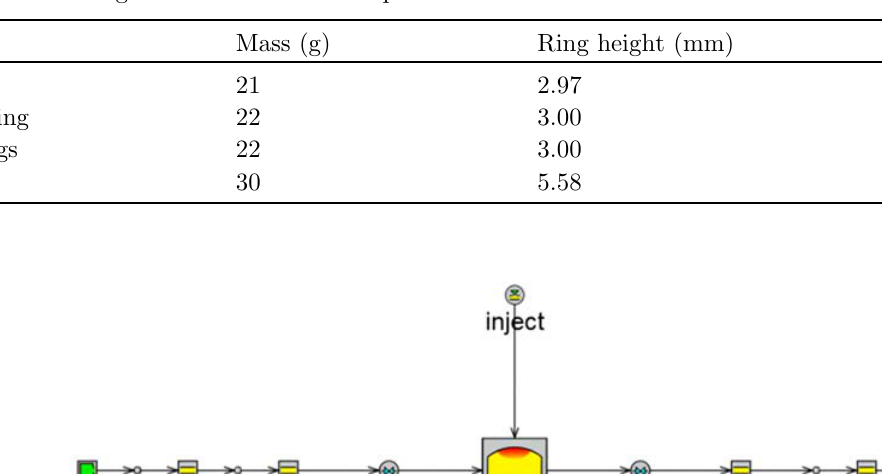
Table 2. Piston ring mass and dimensional parameters.